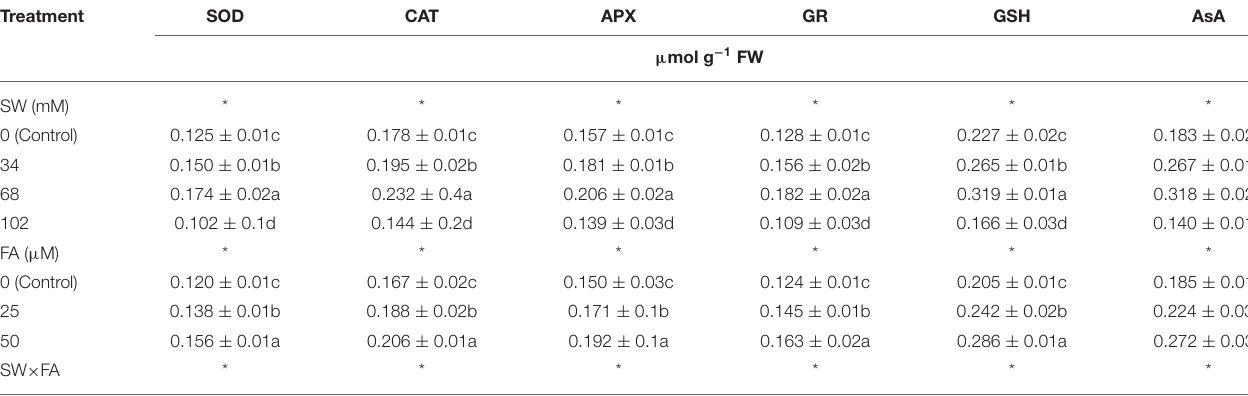
TABLE 4 | The effect of SW irrigation and FA spraying on leaf enzymatic activity and some antioxidant contents of Plectranthus amboinicus plants grown under greenhouse conditions. Treatment SOD CAT APX